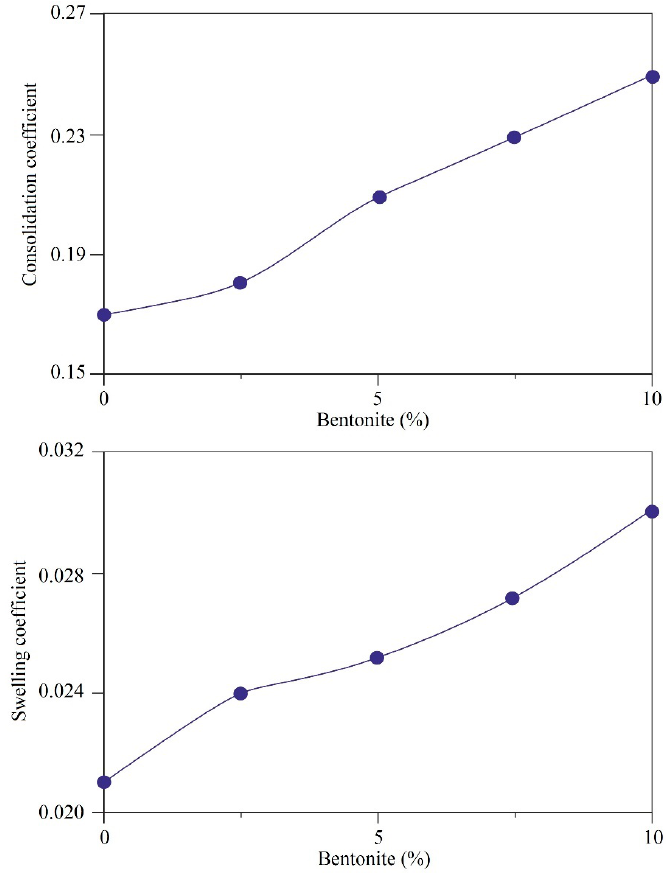
Figure 6. Effect of the Bentonite percentage on consolidation and swelling coefficients.